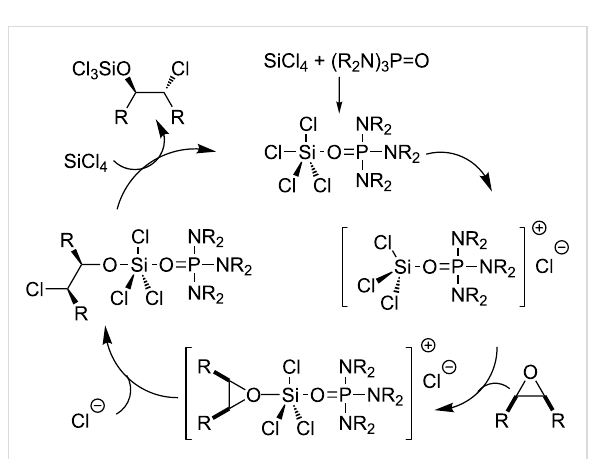
Figure 14: The proposed mechanism of the chiral HMPA-catalyzed desymmetrization of meso -epoxides.